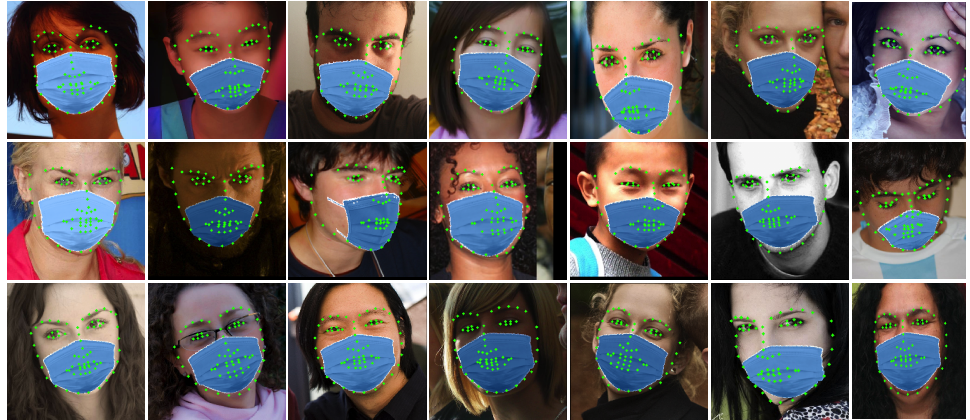
Figure 9. Example images from Masked 300 W.